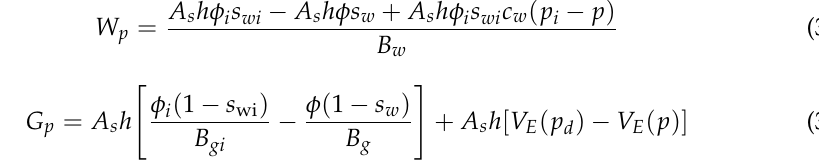
Figure 10. Comparison results of cumulative water production with numerical simulation. The corresponding Wp and Gp at different formation pressures can be obtained us- ing the method proposed in this study. Furthermore, the recoverable reserves and recov- ery under abandonment pressure can be calculated according to Equation (39), and the results of comparing the method proposed in this study with the results of numerical sim- ulations are displayed in Table 2.